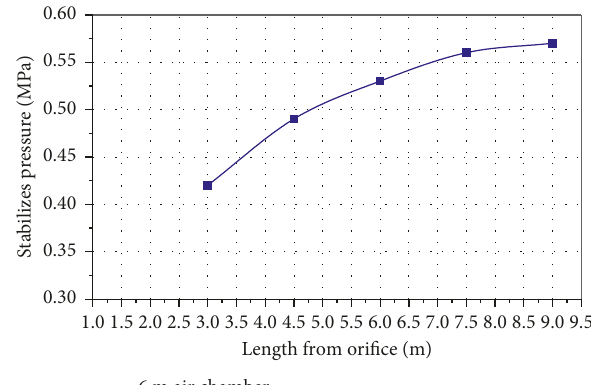
Figure 9: A diagram of the steady pressure change in the 6-meter gas chamber.